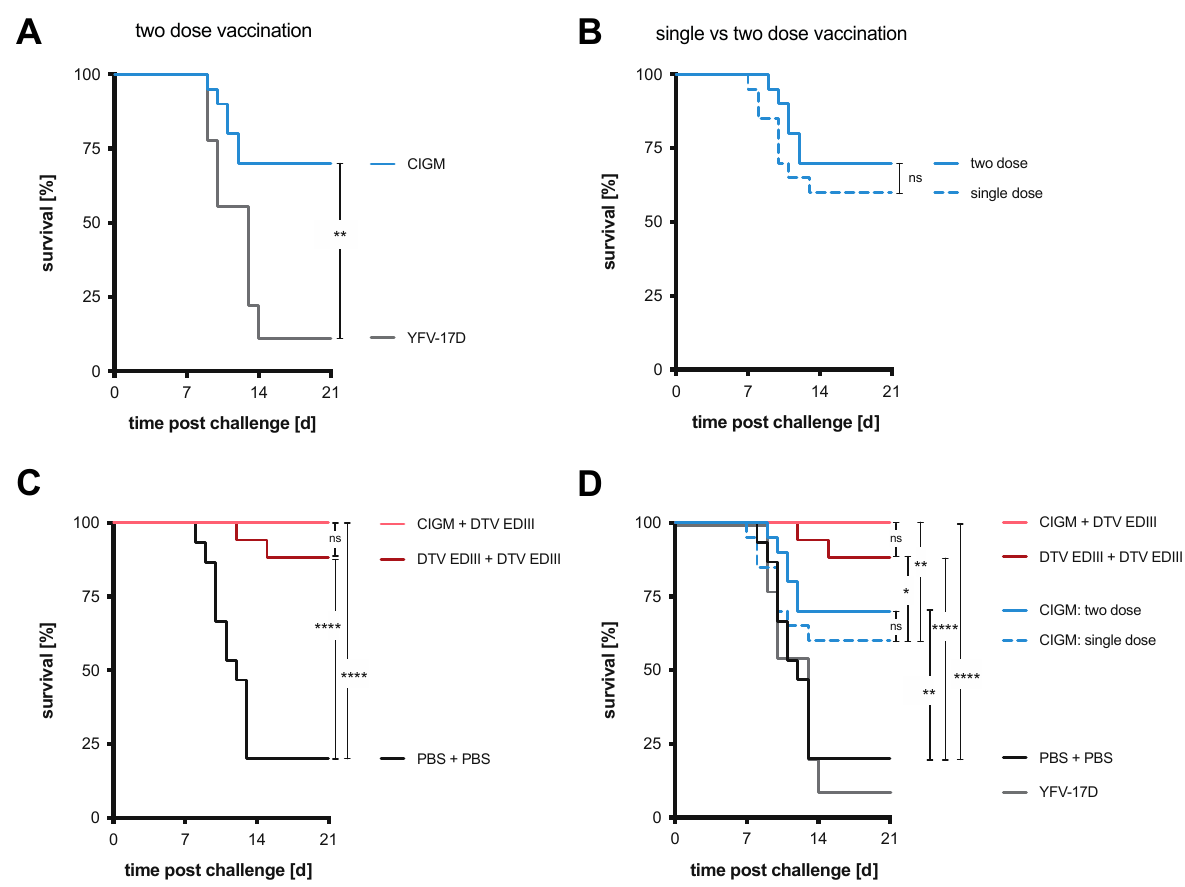
Figure 5. In vivo e ffi cacy of CIGM in di ff erent vaccination regimens. ( A ) Survival curves of BL6 mice challenged with a lethal dose of WT DTV after vaccination with two doses of 10 3 PFU CIGM ( n = 20). YFV-17D was used in a control cohort ( n = 9) at 10 3 PFU. ( B ) Survival curves of BL6 mice challenged with a lethal dose of WT DTV upon vaccination with 10 3 PFU CIGM comparing a single-dose ( n = 20) versus the two-dose ( n = 20) regimen shown in ( A ). Single-dose data is from Figure 4C. ( C ) Survival curves of vaccinated BL6 mice challenged with a lethal dose of WT DTV. Mice were initially vaccinated as indicated with 10 3 PFU CIGM ( n = 19) or 25 ng DTV EDIII ( n = 17), followed two weeks later by a 25 ng dose of DTV EDIII. In a control cohort ( n = 15), mice were mock- vaccinated with PBS in the two-dose regimen. ( D ) Combination of survival curves shown in ( A – C ) to display vaccine e ffi cacy between the di ff erent regimens. Statistical signi fi cance was determined by Log-rank (Mantel-Cox) test. ns, not signi fi cant; *, p < 0.05; **, p < 0.01; ****, p < 0.0001.